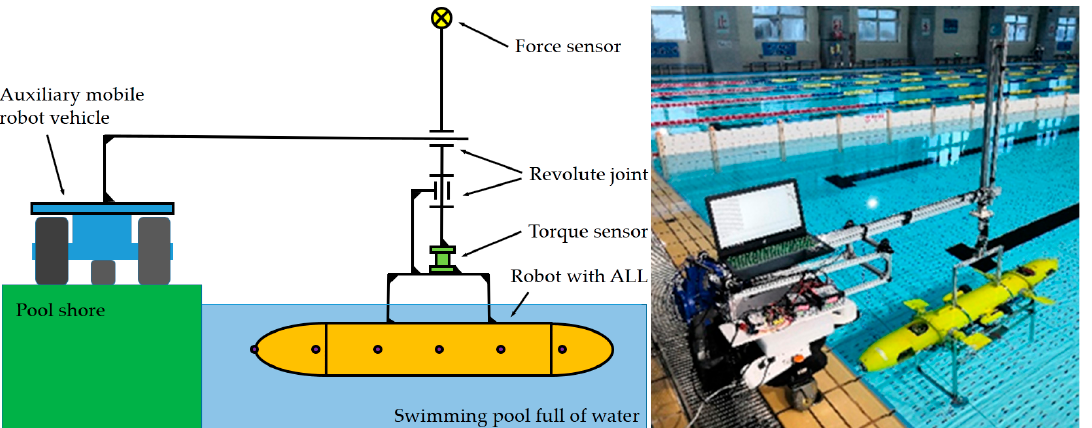
Figure 5. Experimental platform for artificial lateral-line system.